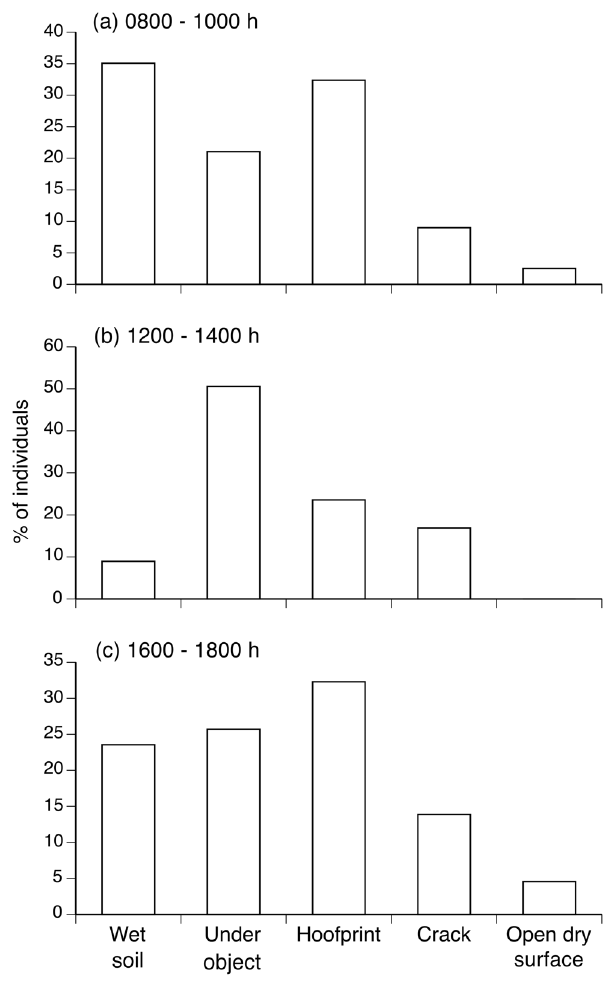
Figure 2. Number of metamorph cane toads using different microhabitats in the field. Surveys were conducted in the morning (a), around midday (b), and in the afternoon (c). ‘‘Under object’’ includes spaces under leaf litter, leaves, plants, logs, branches, pieces of dry mud, and rocks. ‘‘Open dry surface’’ includes dry soil, leaf litter and grass. lacking hoofprints ( F 2,49 =9.99; P = 0.0002; Tukey P , 0.05, Figure 5a). The number of times that metamorph toads were attacked by ants, and the number of times that toads moved to avoid ant attacks, were higher in steep-sided hoofprints than on open substrates or in gently-sloping hoofprints (contacts: F 2,49 = 21.87, P , 0.0001, Tukey P , 0.05; escapes: F 2,49 =11.51, P , 0.0001, Tukey P , 0.05; Figure 5b, c). No successful predation events were recorded on open substrates, whereas many toads were killed in steep-sided hoofprints (Figure 5d). High variances meant that the number of successful predation events did not differ significantly among shelter types ( F 2,49 = 2.86, P = 0.07) unless we used a one-tailed test based on the a priori prediction of higher risk to toads in steep-sided footprints (so, P , 0.04). ANCOVA with ant densities as a covariate showed that the higher rate of attacks by ants in steep-sided hoofprints was not a simple result of higher densities of ants in those hoofprints (shelter type: F 2,46 = 8.99, P = 0.0005; total number of ants: F 1,46 =0.16, P = 0.69; shelter type*total number of ants: F 2,46 = 0.10, P = 0.91). The number of ant-avoidance behaviours by toads increased at higher ant densities ( F 1,48 = 8.31, P = 0.006) but at the same ant